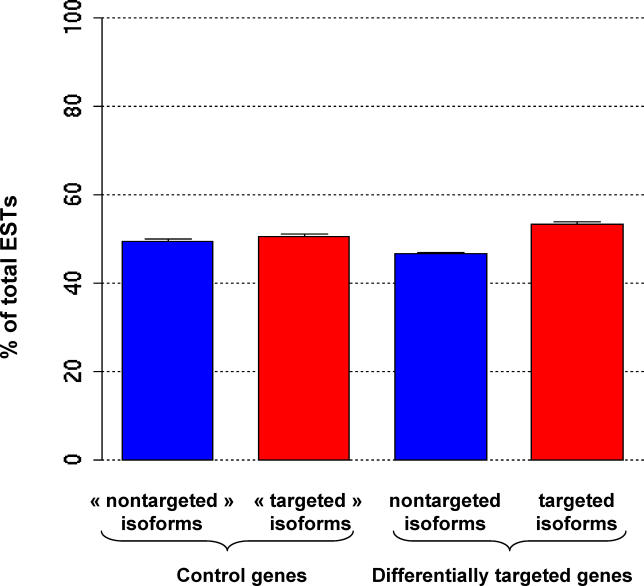
Relative EST-Based Expression Level of Target-Containing (Blue) and Target-Free (Red) IsoformsTotal number of ESTs observed for each gene is scaled to 100. Left: control set contains isoforms from 1,875 alternatively polyadenylated genes, classified as “targeted” or “nontargeted” according to their location relative to a randomly selected position. Student paired test p-value for differential expression = 0.38. Right: test set contains isoforms from 562 genes containing targets for known miRNAs located downstream of first poly(A) site. Student paired test p-value for differential expression = 7.45 × 10−5.